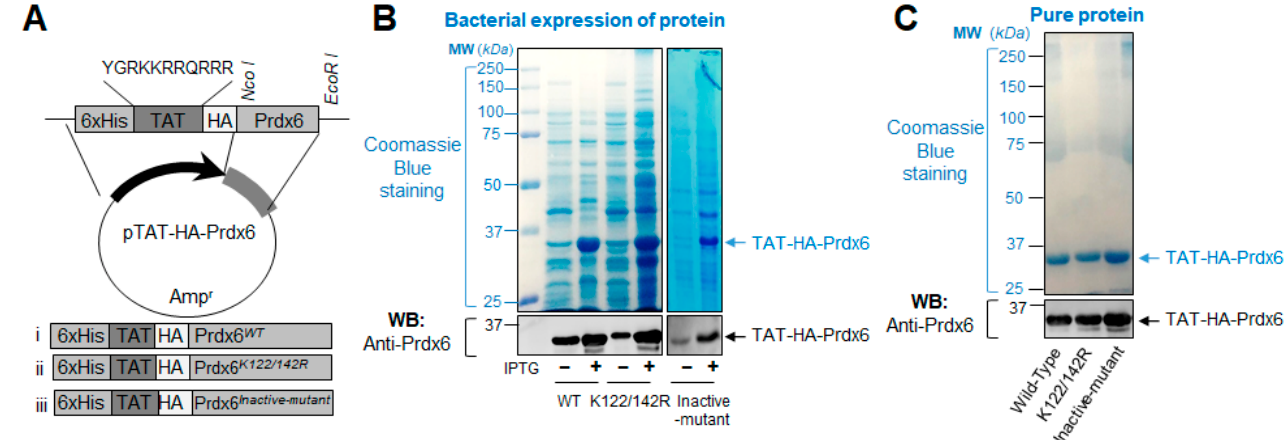
Figure 1. ( A ) An illustration of the TAT-HA-Prdx6 expression vector system. Constructs i, ii, and iii represent TAT-HA-Prdx6 WT , Sumoylation-deficient TAT-HA-Prdx6 K122/142R , and TAT-HA-Prdx6 C47IL/S32A/H26A/D140A (inactive-mutant), respectively. These plasmids were utilized for recombinant protein preparation. ( B , C ) Expression of TAT-HA-Prdx6 WT , and its mutant TAT-HA-Prdx6 K122/142R and TAT-HA-Prdx6 Inactive-mutant fusion recombinant protein in Escherichia coli . ( B ) TAT-HA-Prdx6 WT or its mutant at K122/142R and inactive-mutant (C47IL/S32A/H26A/D140A) fusion bacterial protein expression was analyzed using Coomassie blue staining of SDS-PAGE gel (upper panel) and immunoblot analysis with anti-Prdx6 antibody (lower panel). ( C ) Purified TAT-HA-Prdx6 WT and its mutants TAT-HA-Prdx6 K122/142R and TAT-HA-Prdx6 Inactive-mutant protein were analyzed using Coomassie blue staining (upper panel) and immunoblot analysis with Prdx6 antibody (lower panel).